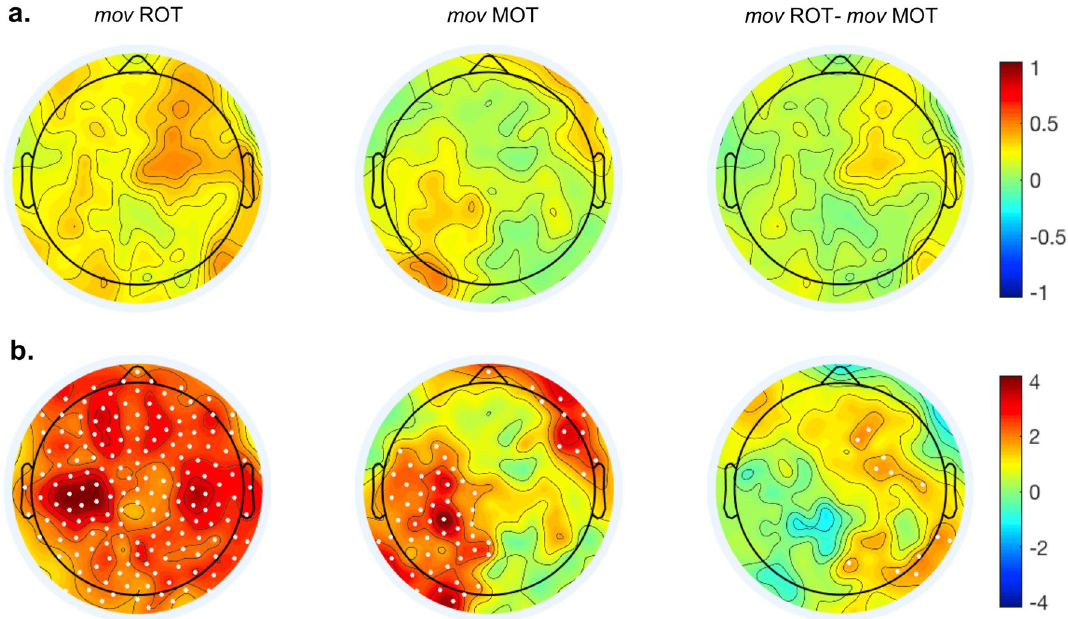
Figure 3. Within-block changes of average beta oscillatory activity in mov . ( a ) Topographic distribution of the between-block changes—computed as the difference between mov 0 and mov 3- in both ROT mov and MOT mov , and their differences (ROT mov vs. MOT mov) . ( b ) Maps of the Bonferroni-corrected permutation t-values comparing the between-blocks changes in ROT mov, MOT mov and their relative difference. Significant electrodes are reported as white dots ( p ≤